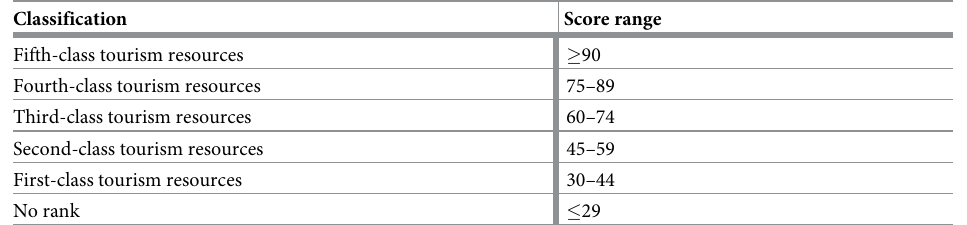
Table 2. Tourism resources monomer level division